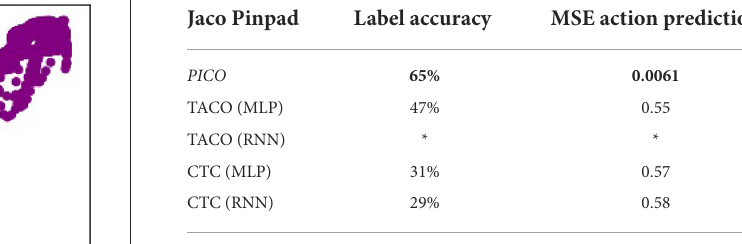
TABLE 2 Method comparisons using the Jaco Pinpad